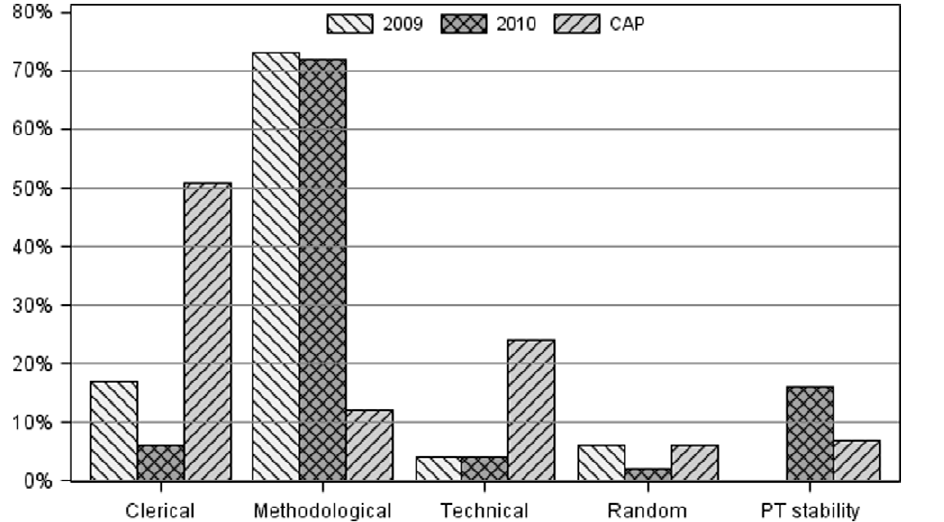
Figure 1. Comparison of proportion of errors due to each type of error for unsatisfactory results at study centers in 2009, 2010, and US averages according to CAP data.